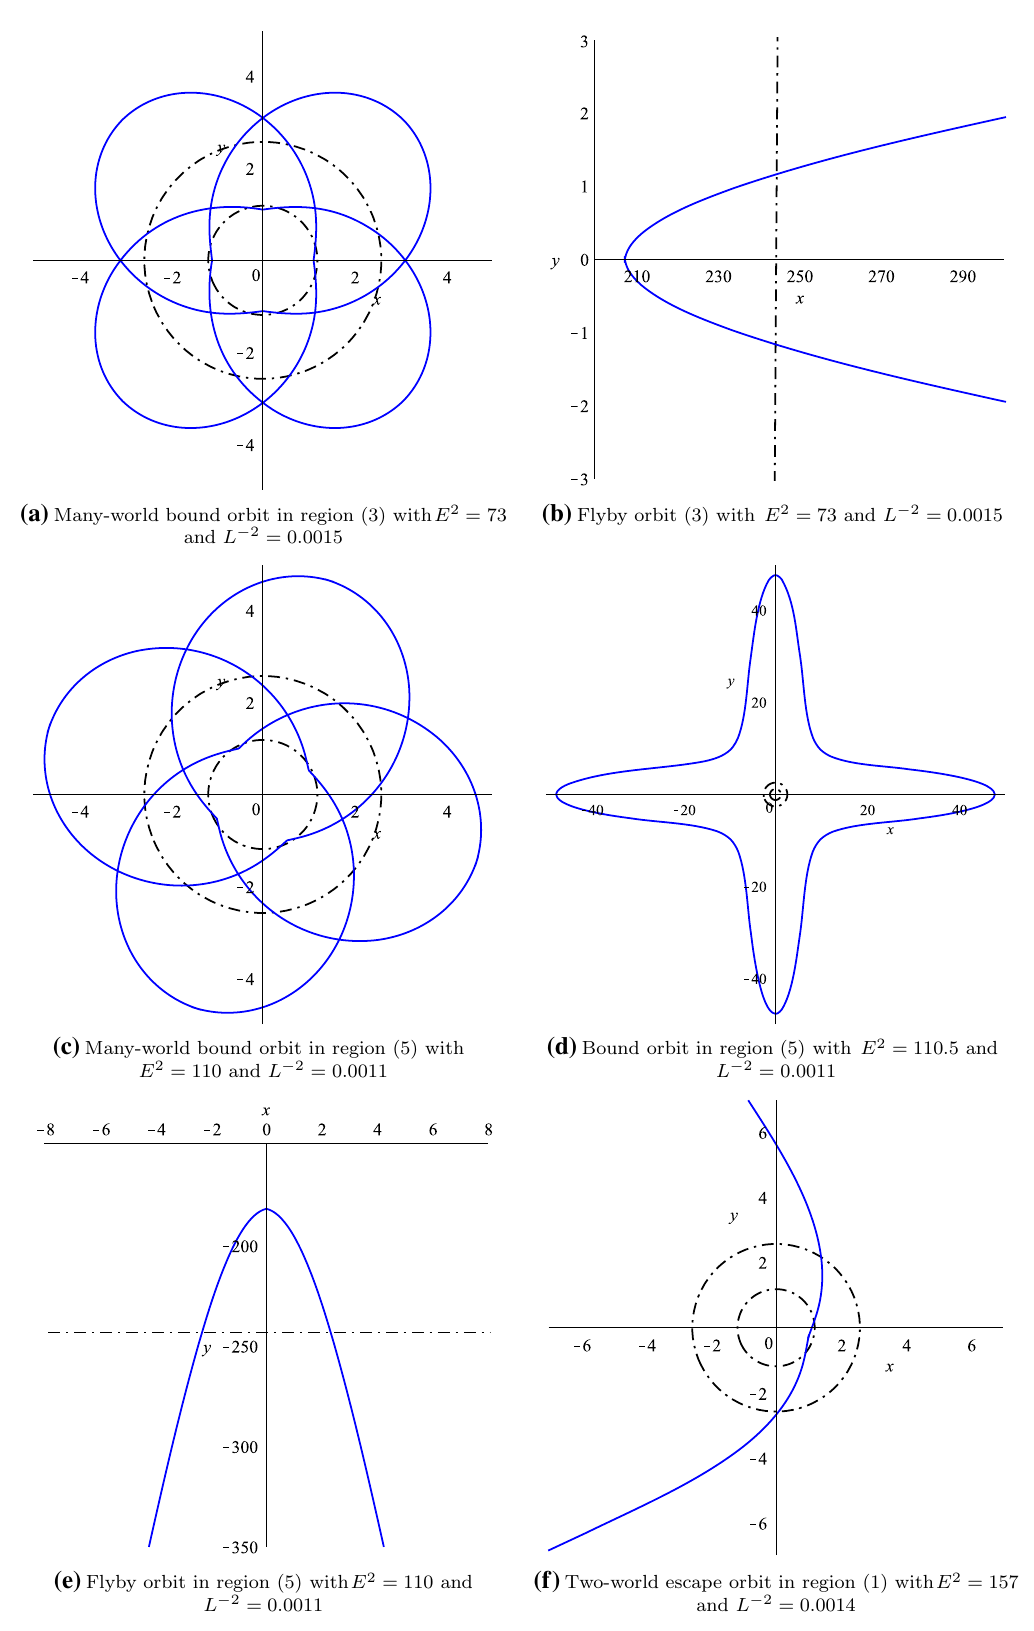
Fig. 14 Timelike geodesics in the charged BTZ black hole in massive gravity with (cid:4) = 10 − 2 , m 0 = 2, m (cid:5) = 2 . 54, q = 1 . 5 and r 0 = 0 . 95. The dashed dot lines represent